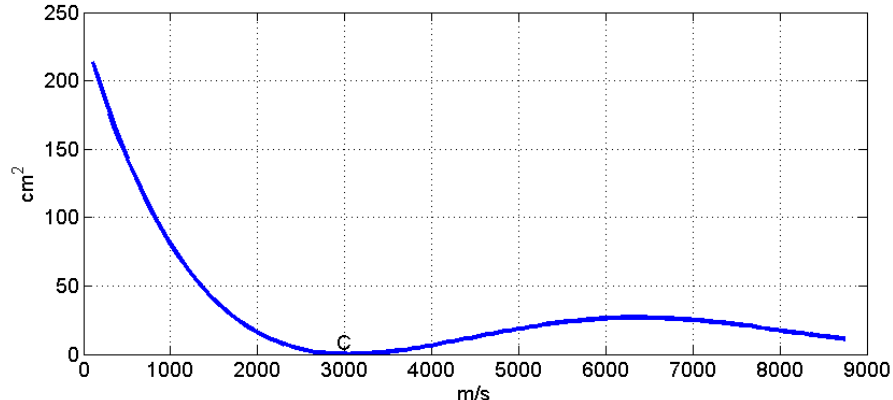
Figure 6. S as a function of c for 50  c  8,750 m/s in the above example. C = 3,000 m/s.